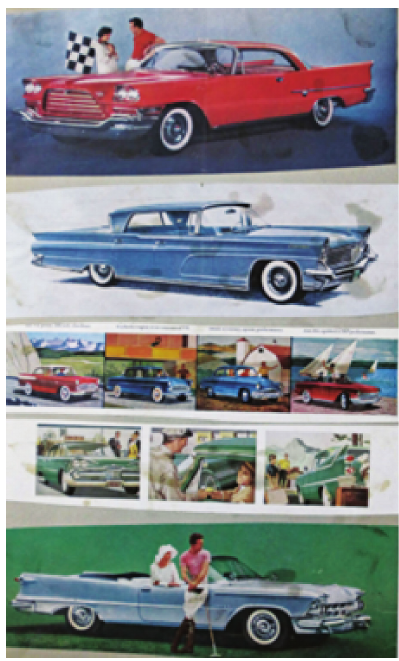
Figure 6. Cullen, scrapbook magazine clippings, 1930s. Source : Cullen personal